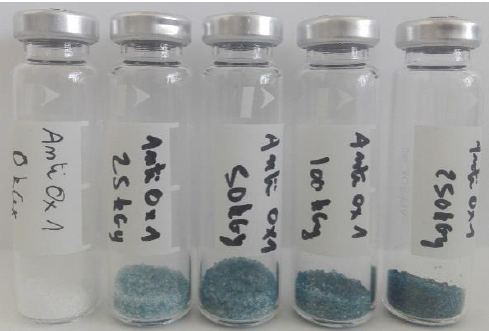
Figure 2. Non-irradiated and γ-irradiated 2,6-di-tert-butyl-p-cresol in solid phase (left to right: 0, 25, 50, 100, and 250 kGy).